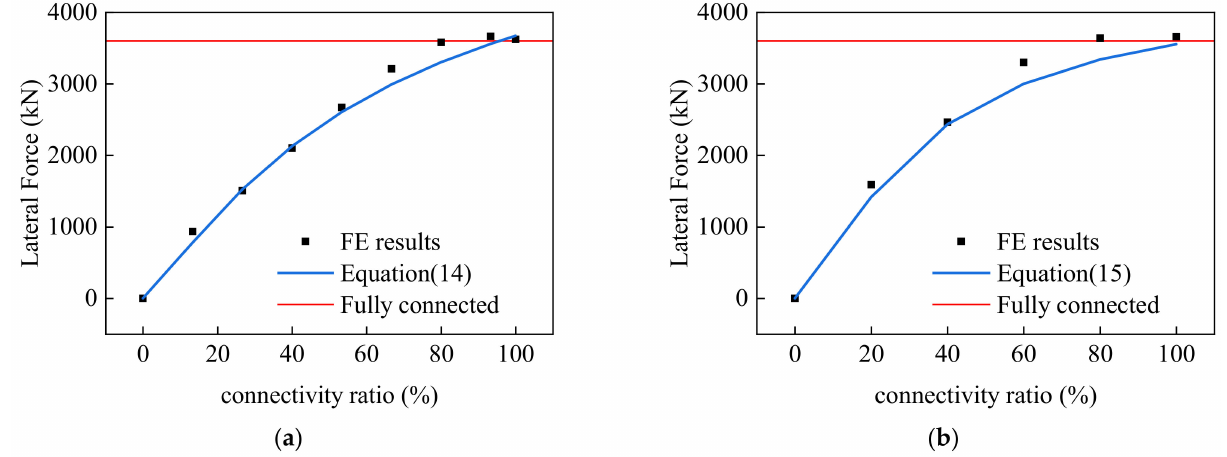
Figure 15. Comparison results of prediction equation and FE method for: ( a ) S3, and ( b ) S4